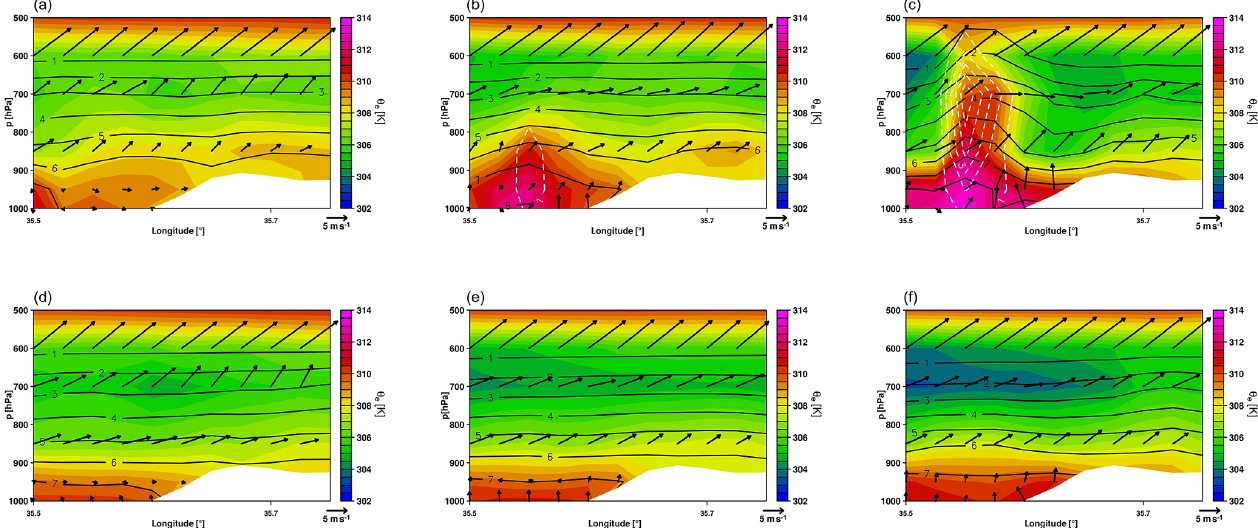
Figure 11. Vertical cross section of equivalent potential temperature (colour scale; K), specific humidity (black isolines; gkg − 1 ), horizontal wind vectors (north pointing upwards; ms − 1 ) and vertical velocity (dashed white contours with 1ms − 1 increments) of the REF 19 . 11 (a, b, c) and SEN 19 . 11 (d, e, f) simulations at 01:00 (a, d) , 02:00 (b, e) and 03:00UTC (c, f) . The location of the cross section is indicated in Fig.